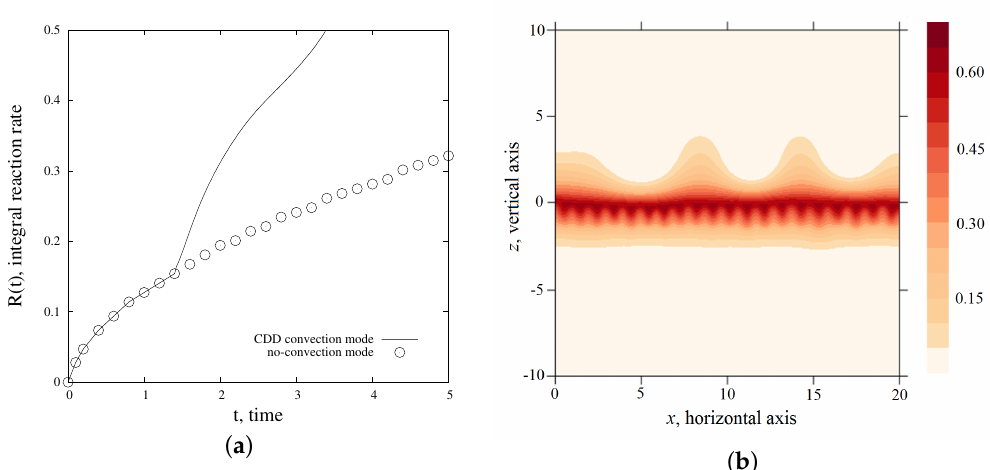
Figure 3. ( a ) Evolution of the reaction rate R ( t ) for the batch reactor with perfectly planar Hele-Shaw unit working in either the pure reaction-diffusion mode (open circles) or the concentration-dependent diffusion (CDD) convection mode (solid line); ( b ) Salt concentration field at time t = 3 for the same